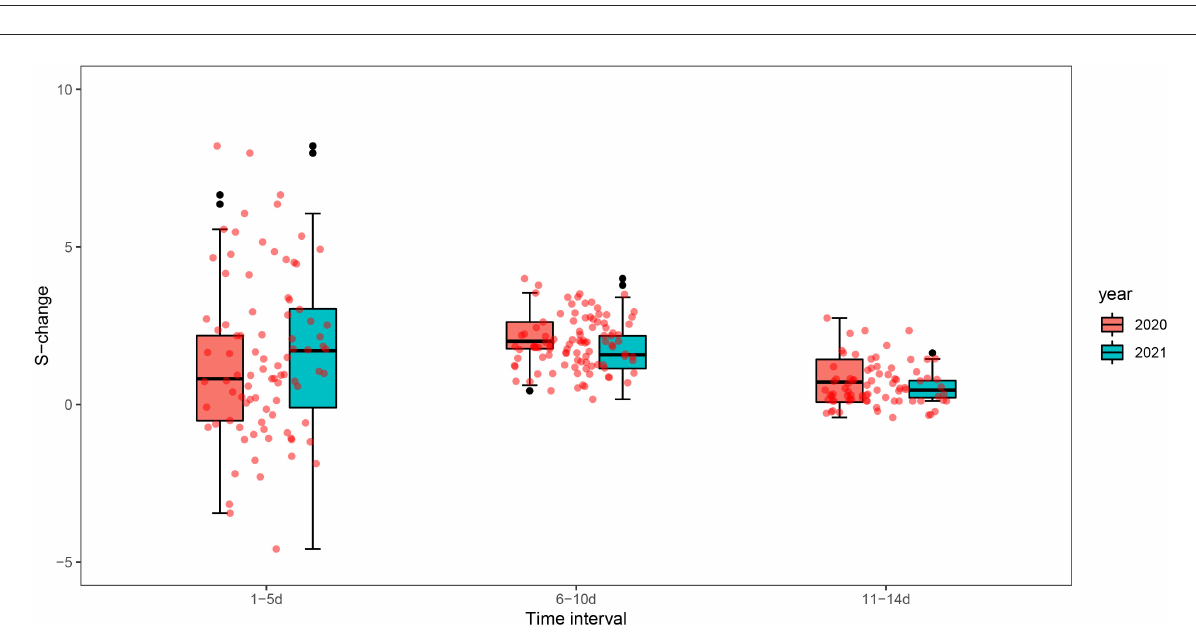
FIGURE6 Box plots of spatial-temporal clustering changes ( S -change) before and after the peak of the epidemic in Guangzhou in 2020 and